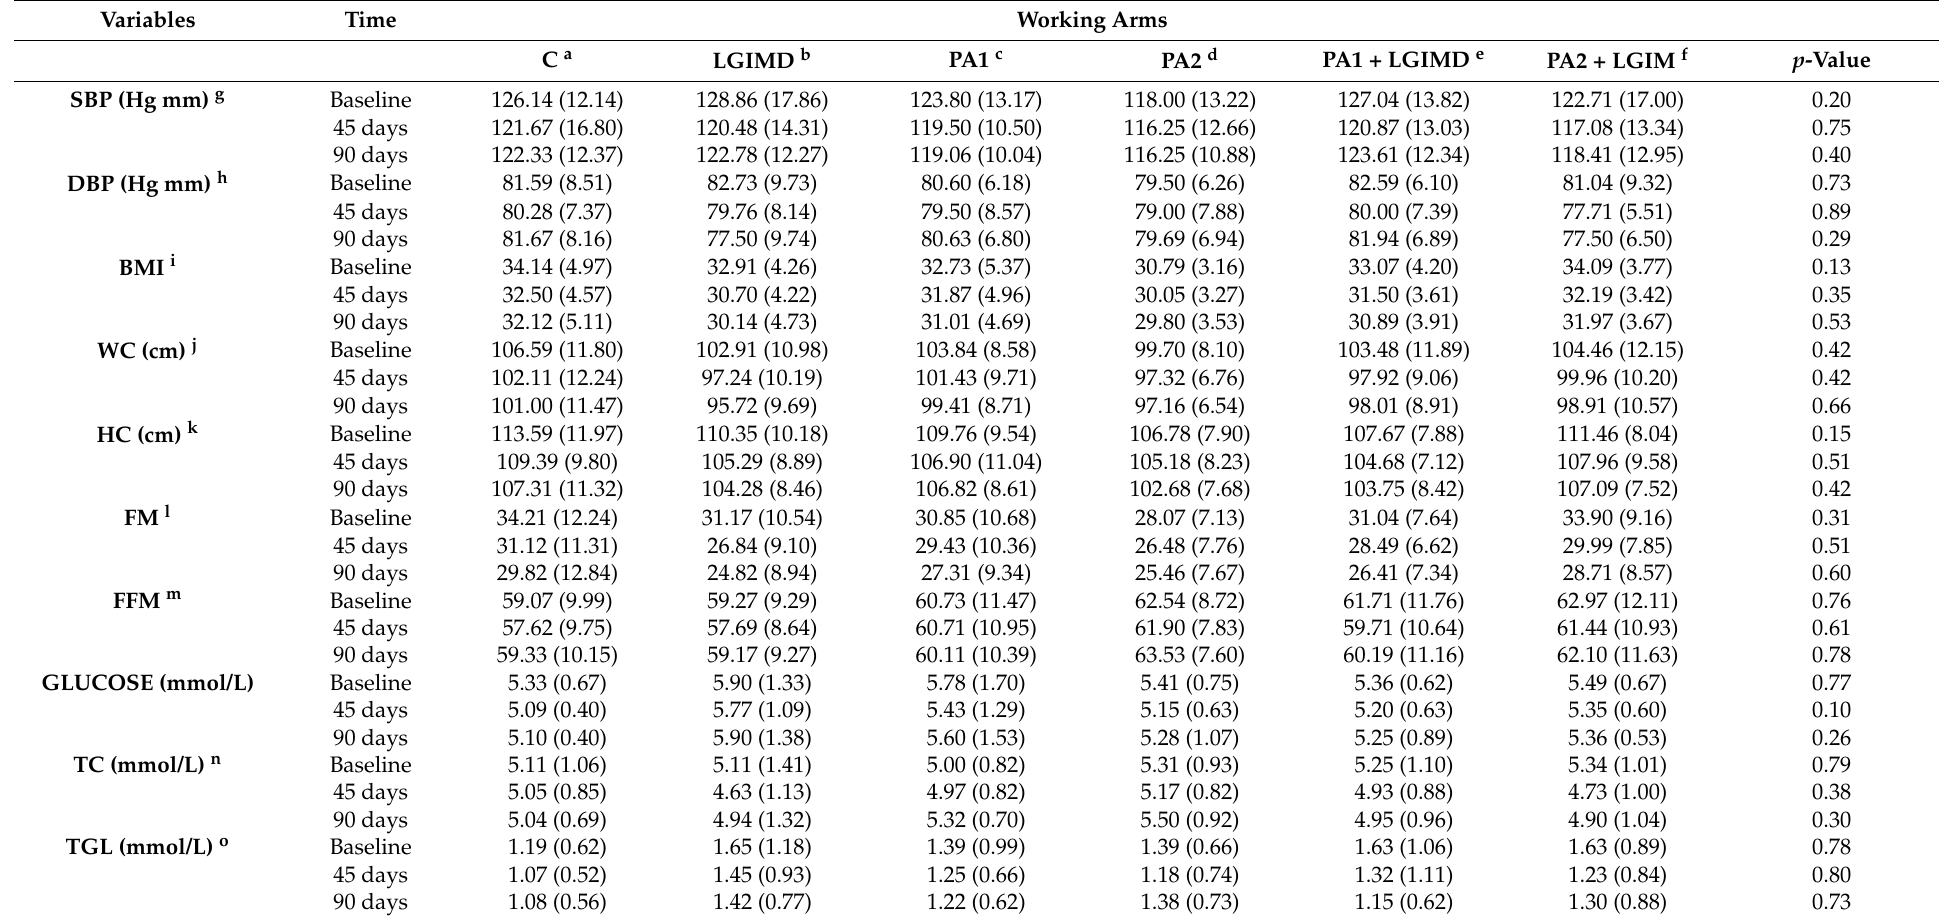
Table A1. Anthropometric and Biochemical Characteristics of Participants by Intervention Arms and Time. NutriAtt Trial, Castellana Grotte,